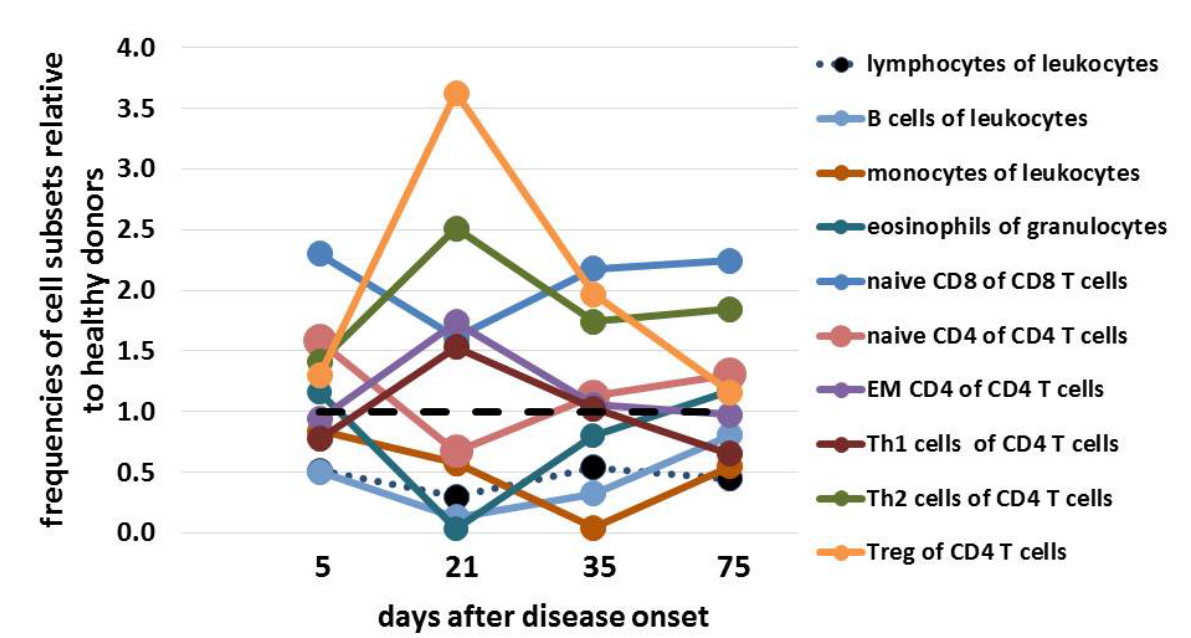
Figure 3. CyTOF results showing course of differential immunological cell subsets.